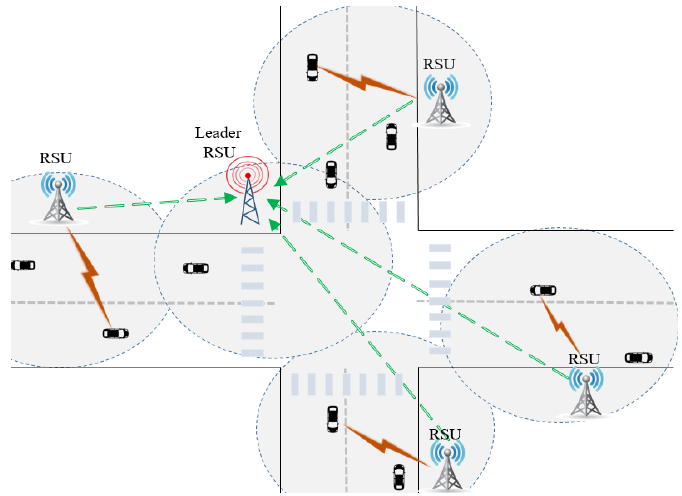
Figure 2. Group key request to the leader